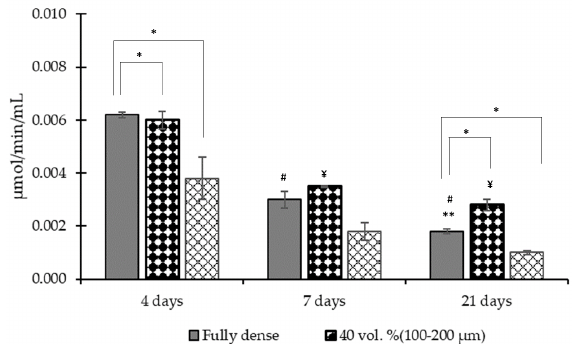
Figure 5. Alkaline phosphatase (ALP) quantification at 4, 7 and 21 days of MC3T3 growing on fully- dense surface, sample with porous 40 vol.% (100–200) µm and 40 vol.% (355–500) µm. A * p -value of < 0.05. # p < 0.005 fully-dense 4 days vs. 7 days and 21 days; ¥ p < 0.05 40 vol.% (100–200) µm 4 days vs. 7 days and 21 days; ** p < 0.005 40 vol.% (355–500) µm 4 days vs. 21 days.